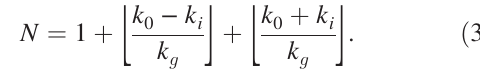
∈ ½ 0 ° ; 90 ° (cid:2) and i